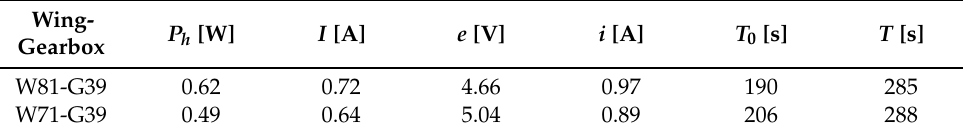
Table 7. Two batteries B2 in series and Motor M2. Lift: L = 20 gr. I is the motor current and i is the battery discharge current. T is the estimated flight time.